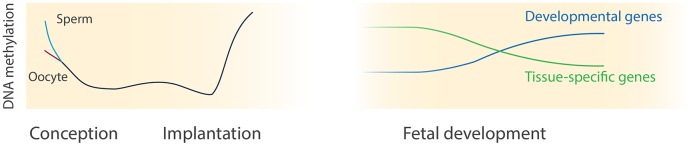
DNA methylation dynamics during human development.This illustration depicts the current comprehensive knowledge of DNA methylation during human pre- and postimplantation development. The knowledge about DNA methylation during human preimplantation (left panel) is derived from [9–12] whereas our study sheds light on postimplantation development (right panel).